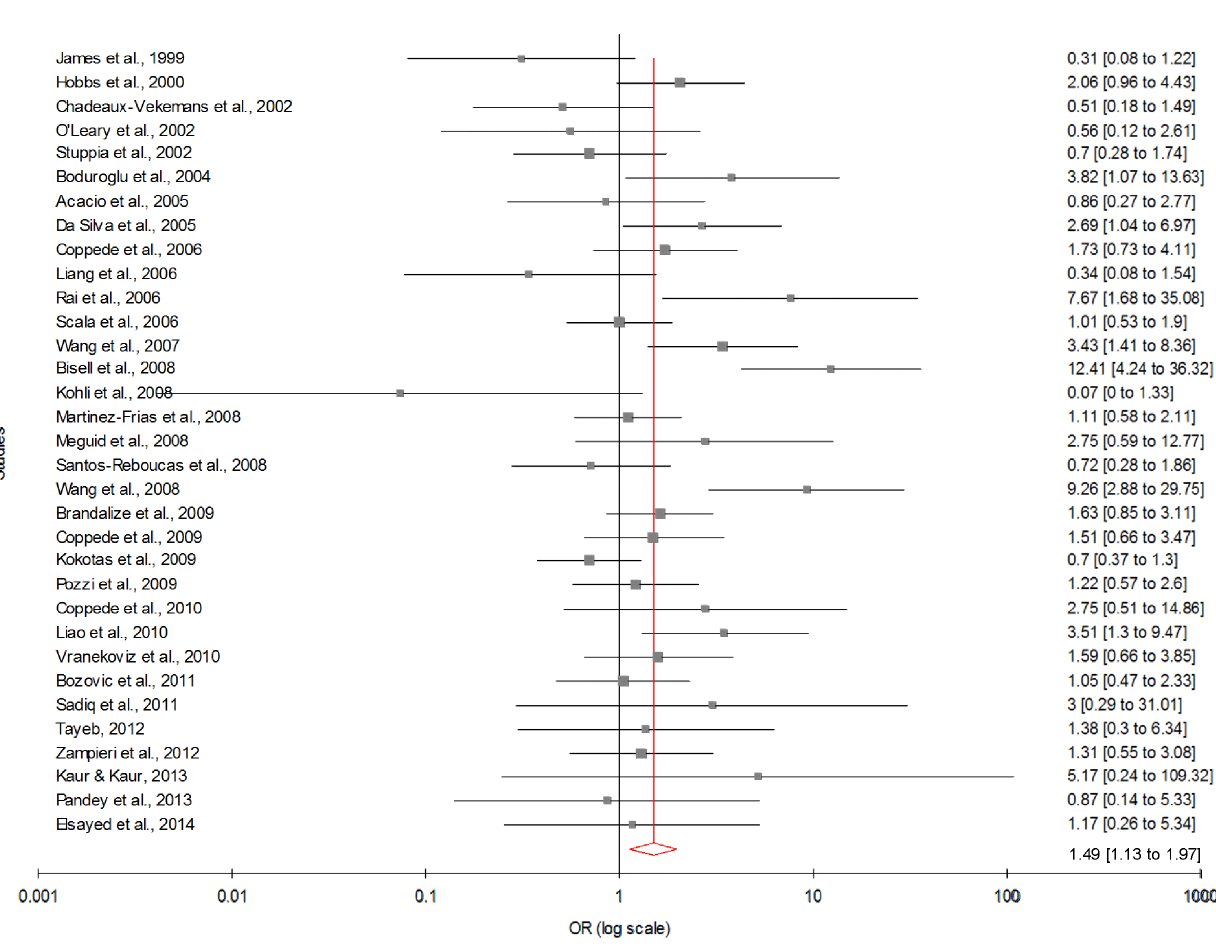
(Figure 2) (Table 3). In cumulative meta-analysis using random effect model, the association of maternal T allele with DS turned statistically significant with the addition of study of Wang et al. (2008) and remained significant thereafter.